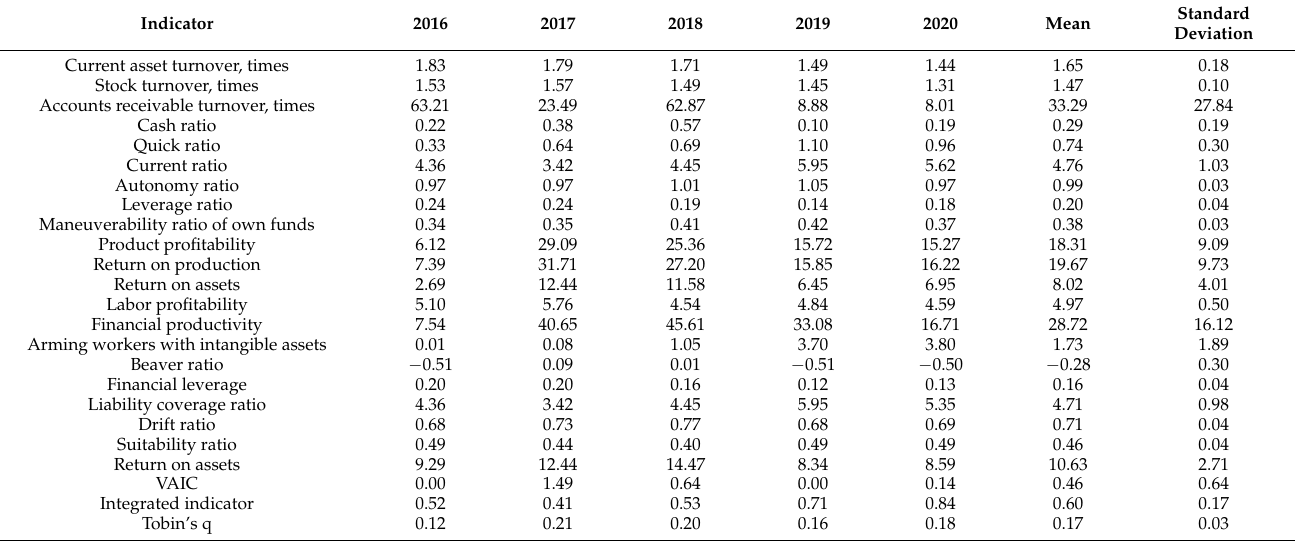
Table 1. Initial data for calculating the development level of the enterprise (fragment, company A).